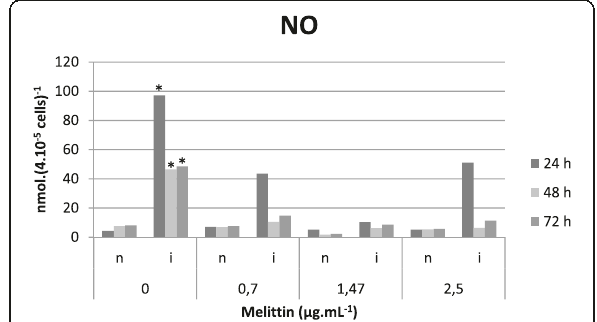
Fig. 5 Determination of NO levels in the supernatant of uninfected macrophages ( n ) and infected macrophages ( i ) after melittin treatment (0, 0.7, 1.47 and 2.5 μ g.mL − 1 ) at 24, 48 and 72 h. Data are presented as mean of three independent measurements.* p < 0.05 for infected cells versus non-infected cells (24, 48 and 72 h) without melittin addition. All treated infected cells (24, 48 and 72 h; 0, 0.7, 1.47 and 2.5 μ g.mL − 1 ) are statistically different ( p < 0.05) of the corresponding non-treated cells